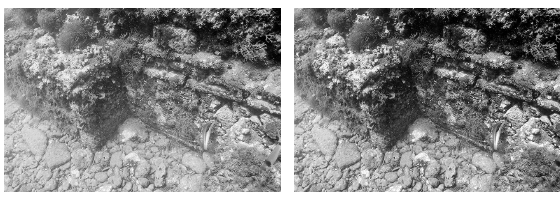
Figure 7: Image of the luminance channel before (at left) and after (at right) contrast enhancement by histogram stretching.